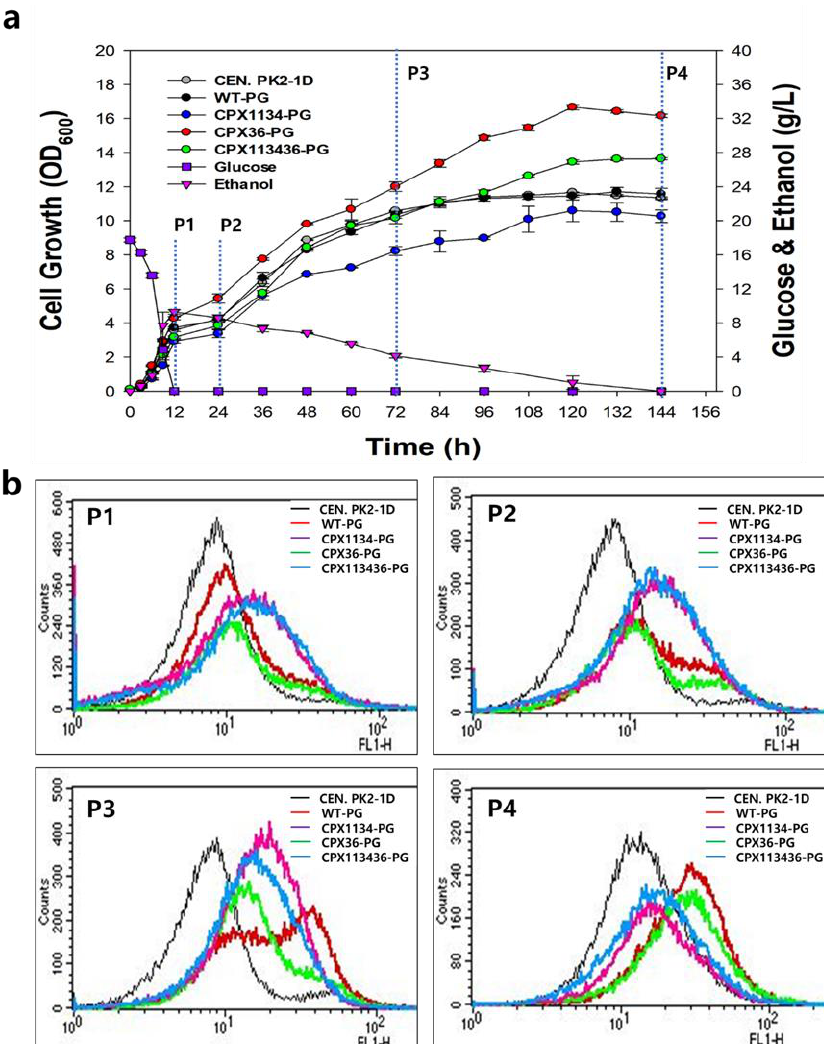
Figure 4. Effect of oleic acid supplementation on peroxisome biogenesis in peroxisome-engineered CPX36-PG, CPX1134-PG, and CPX113436-PG strains in a bioreactor. ( a ) Cell growth of CEN.PK2-1D (wild-type [WT] strain), WT-PG (WT strain with PG), CPX36-PG, CPX1134-PG, and CPX113436-PG in four growth phases (P1: glucose consumption, P2: diauxic shift from glucose to ethanol, P3: post-diauxic shift, and P4: starvation growth phase). Data are presented as the mean ± standard deviation of biological triplicates. ( b ) FACS chromatograms of CEN.PK2-1D (a negative control), WT-PG, CPX36-PG, CPX1134-PG, and CPX113436-PG in four growth phases.